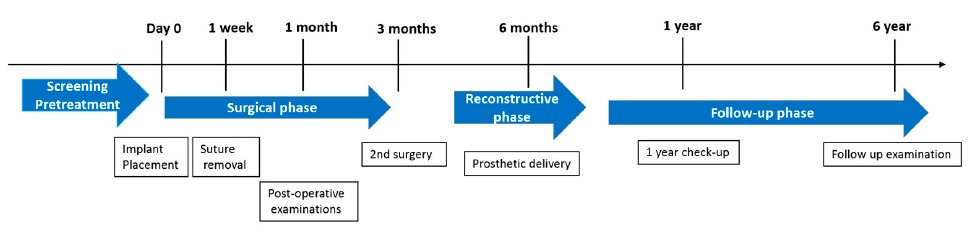
Figure 1. Time sequence of treatment and 6 year follow-up.